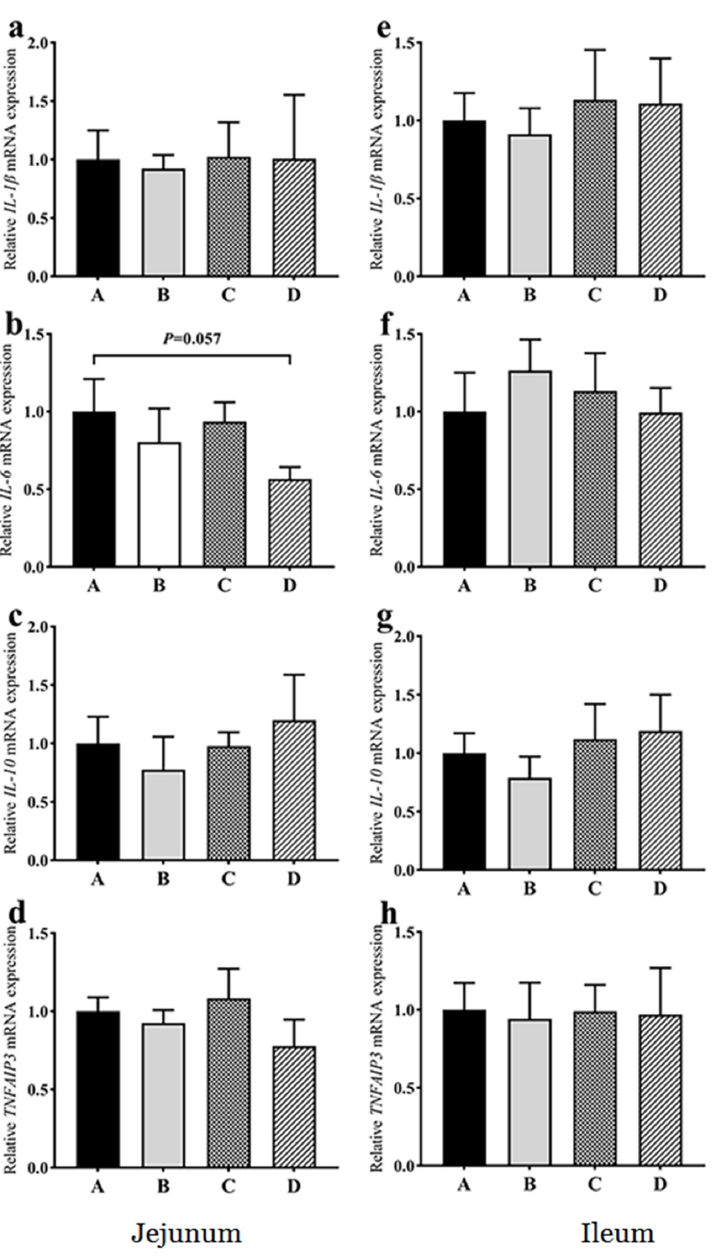
Figure 3. Effects of dietary probiotics on the mRNA expression of inflammatory cytokines in the jejunum ( a – d ) and ileum ( e – h ) of geese at the age of 70 days. Note: a and e for IL-1 β gene; b and f for IL-6 gene; c and g for IL-10 gene; d and h for TNFAIP3 gene. Group A (as control) was fed a basal diet, the treatment groups (B, C and D) were fed the basal diet supplemented with 250 mg/kg Clostridium butyricum (viable count 3.0 × 10 6 CFU/g), 250 mg/kg Bacillus subtilis (viable count 2.0 × 10 7 CFU/g), or the combination of 250 mg/kg Clostridium butyricum plus 250 mg/kg Bacillus subtilis , respectively. The relative mRNA transcript abundance of each gene was determined by quantitative PCR and presented as fold change over control group A. The internal control gene is GAPDH . n = 6. The data are presented as the mean ± SEM.